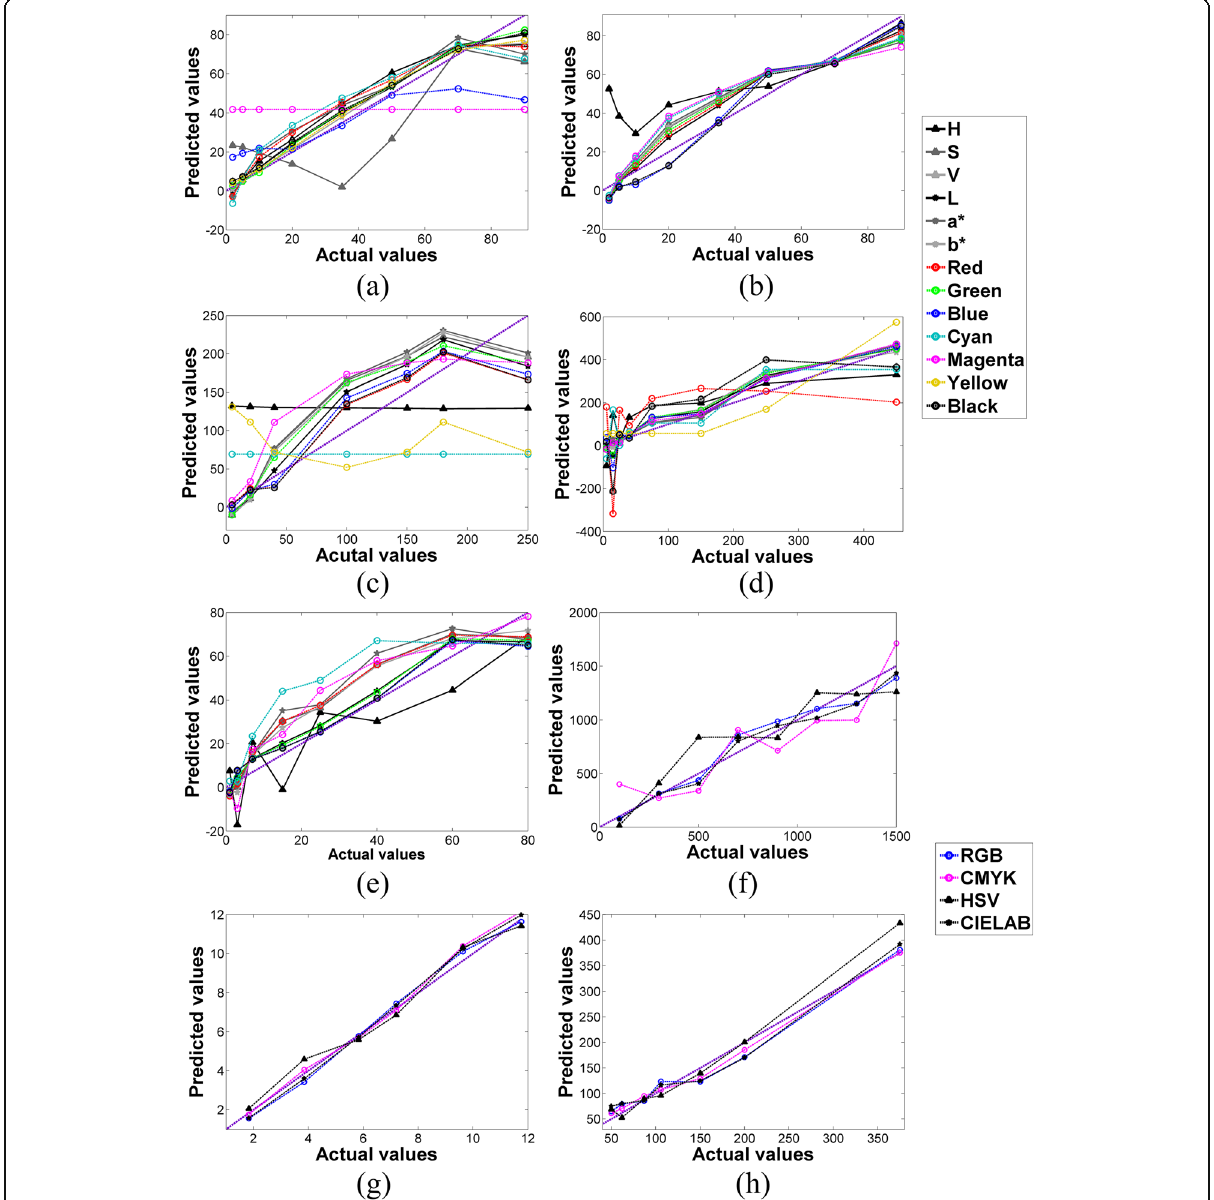
Fig. 5 Correlation graphs comparing the predicted values and actual values presented in Supplementary Materials Table S1 using ULR prediction a Mn 2+ , b Fe 2+ /Fe 3+ , c Cu 2+ , d NO 3- , and e PO 43- and PLS prediction of f SO 42- , g pH, and h total hardness test